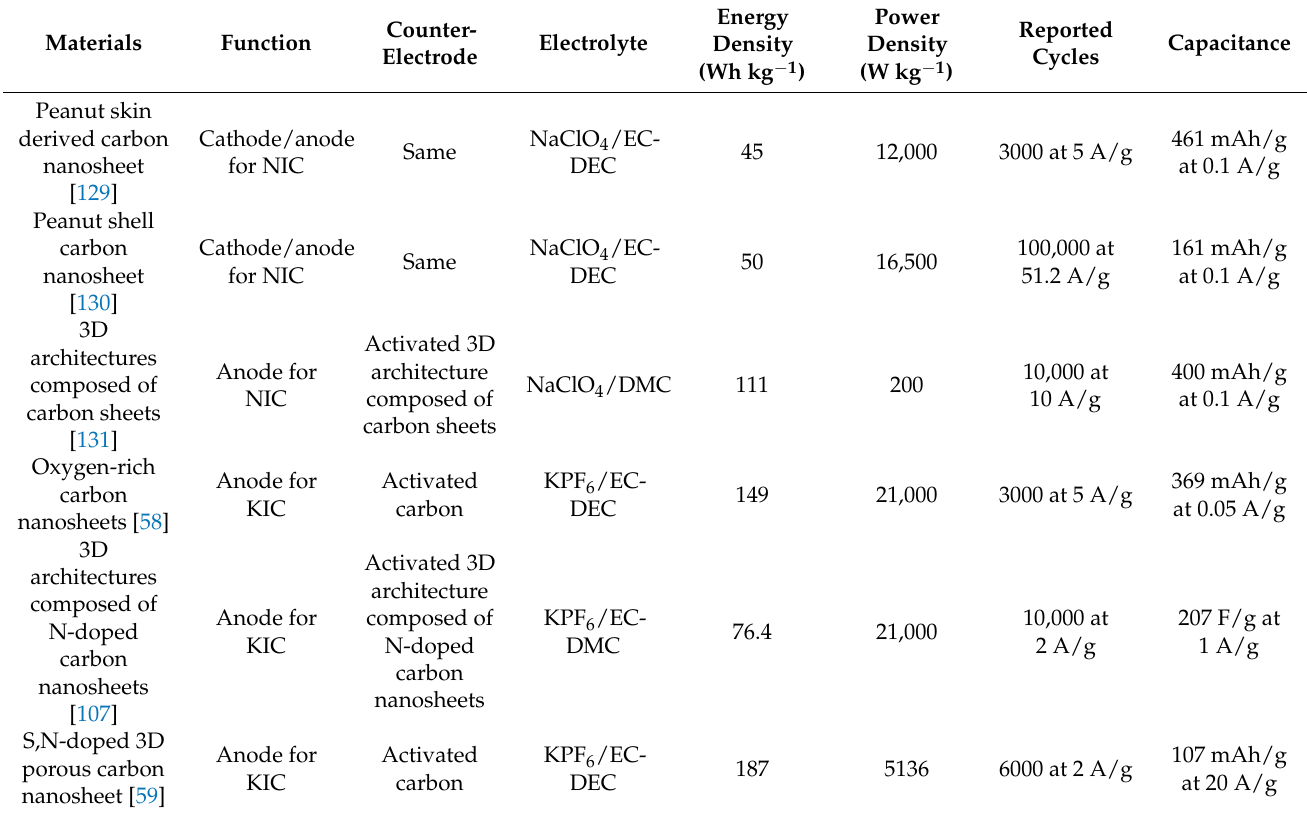
Table 2. Carbon nanosheets for post-Li hybrid